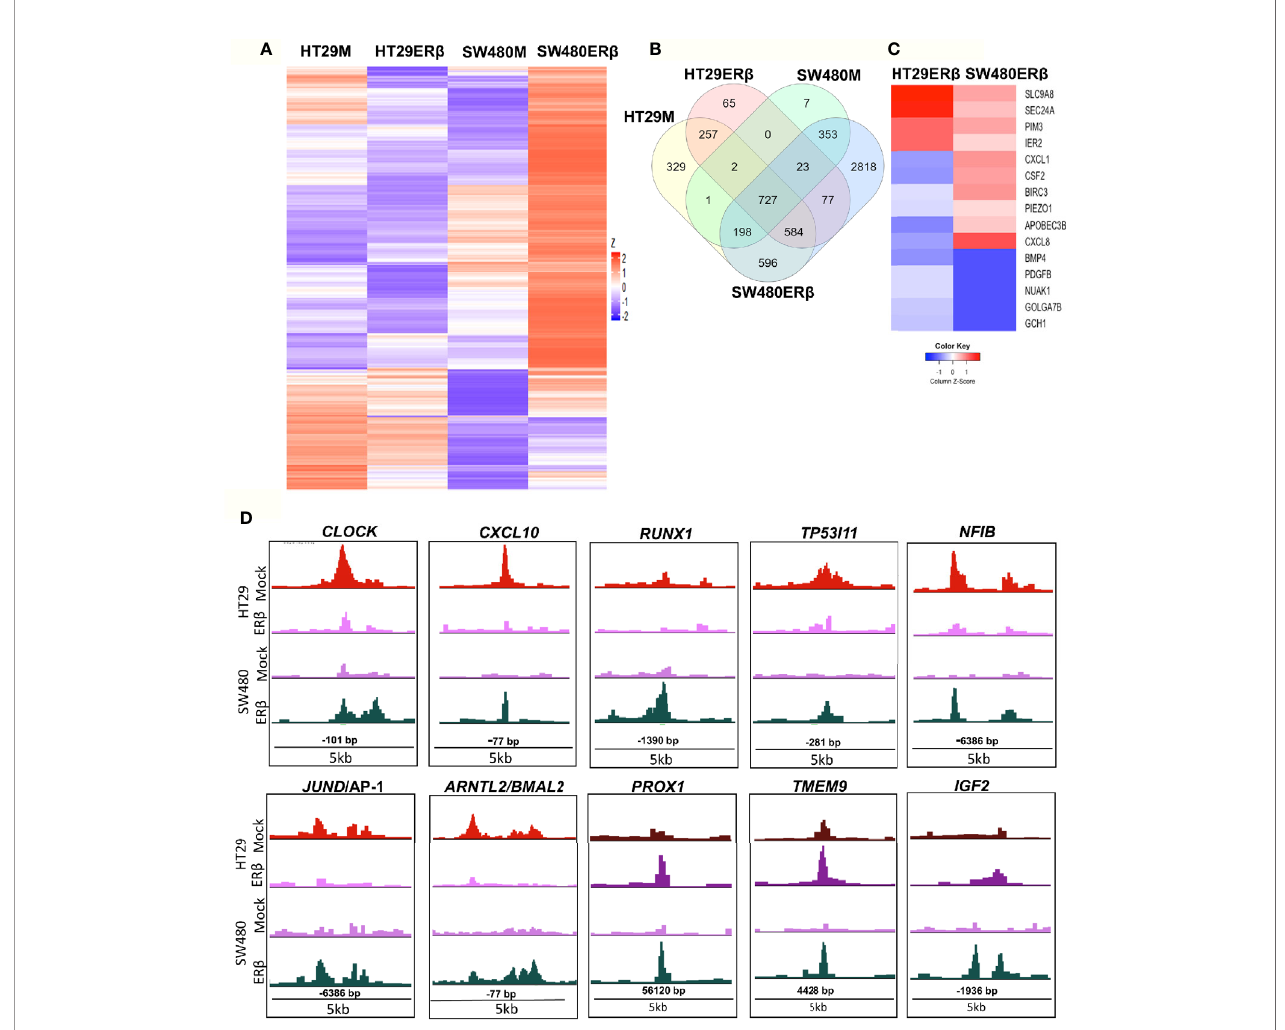
FIGURE 7 | ER b in fl uences P65 chromatin binding in colon cancer cells. (A) Heatmap representing p65 chromatin binding over the genome in absence or presence of ER b , in HT29 and SW480 cells. (B) Venn diagram comparing p65 chromatin binding sites in HT29, SW480 cell lines with and without ER b . (C) Heatmap illustrating the impact of ER b on TNF a modulated genes with identi fi ed p65 chromatin binding sites in HT29 and SW480 cells, respectively. Z score values were calculated from the logarithmic fold changes, which represent a value ’ s relationship to the mean of a group of values. A positive Z score indicates the values above the mean and negative if it is below the mean. (D) Examples of p65 chromatin binding sites that was identi fi ed only in presence of ER b in SW480 cell lines, but bound the same sites in HT29 in absence of ER b and p65 chromatin binding sites enhanced by ER b in both HT29 and SW480 cells illustrated using the UCSC genome